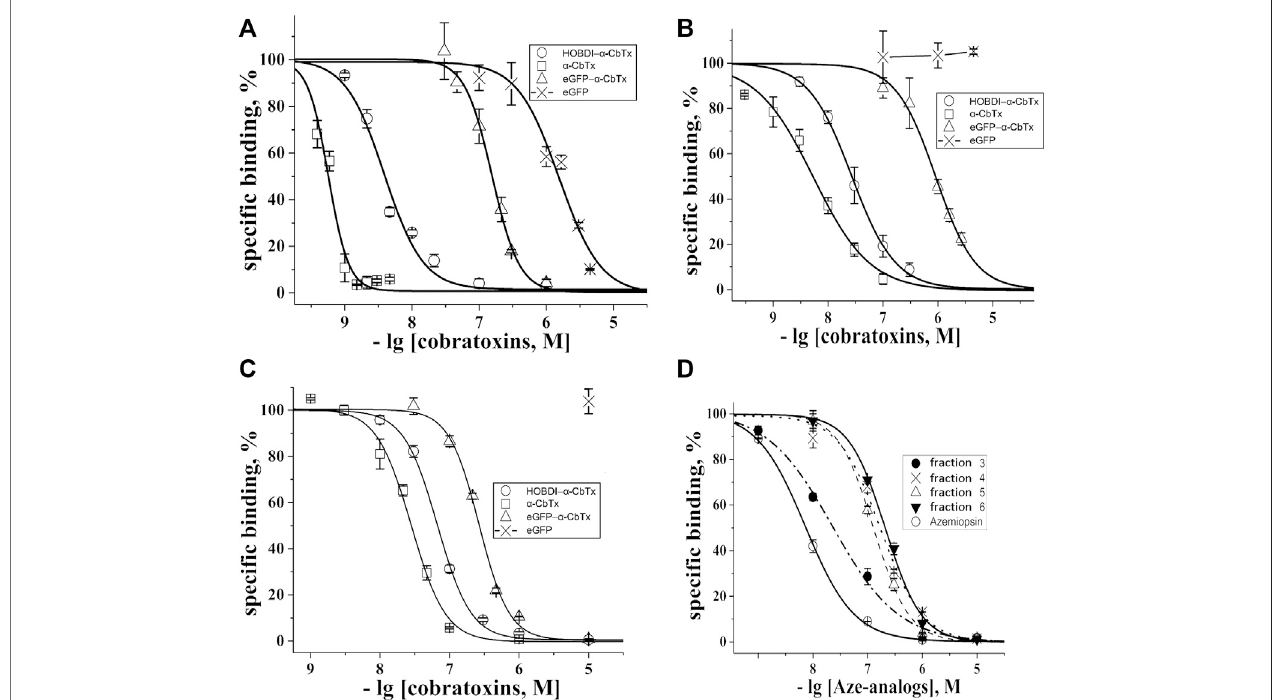
FIGURE 4 | Inhibition of the initial rate for 125 I- α -BgTx binding to (A) T. californica nAChR, (B) human α 7 nAChR and (C) L. stagnalis AChBP with α -CbTx and its fl uorescent analogs (eGFP – α -CbTx, HOBDI-BF – α -CbTx) as well as eGFP. (D) Inhibition of initial rate for 125 I- α -BgTx binding to T. californica nAChR with Aze and its 2 p -HOBDI-BF 2 derivatives from fractions 3 – 6 (see Figure 3A ). Each point is a mean ± S.E.M. value of three measurements for each concentration. The curves were calculated from the means ± S.E.M. using OriginPro 2015, and the respective IC 50 values in nM are presented in Table 2 .